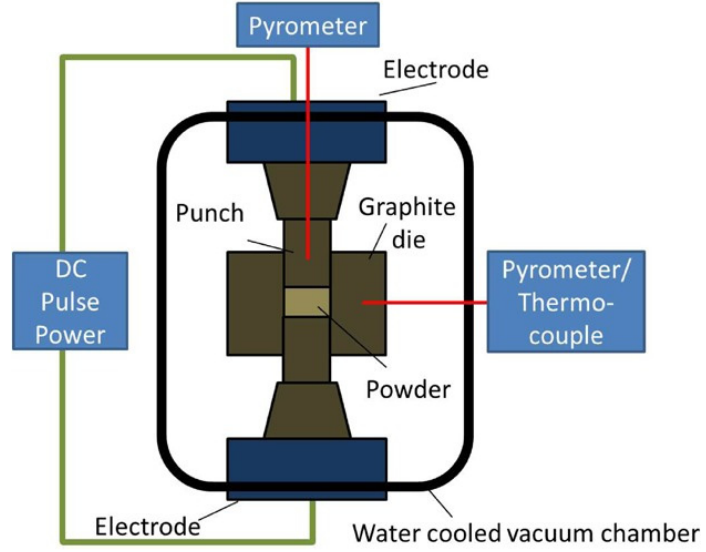
Figure 1. Schematic of spark plasma sintering unit. Reprinted with permission from Advanced Engineering Materials [31].